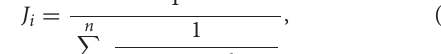
previously explained (Equation 8): g E ki